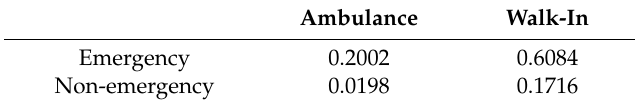
Table 2. Proportion of patients according to their severity and arrival